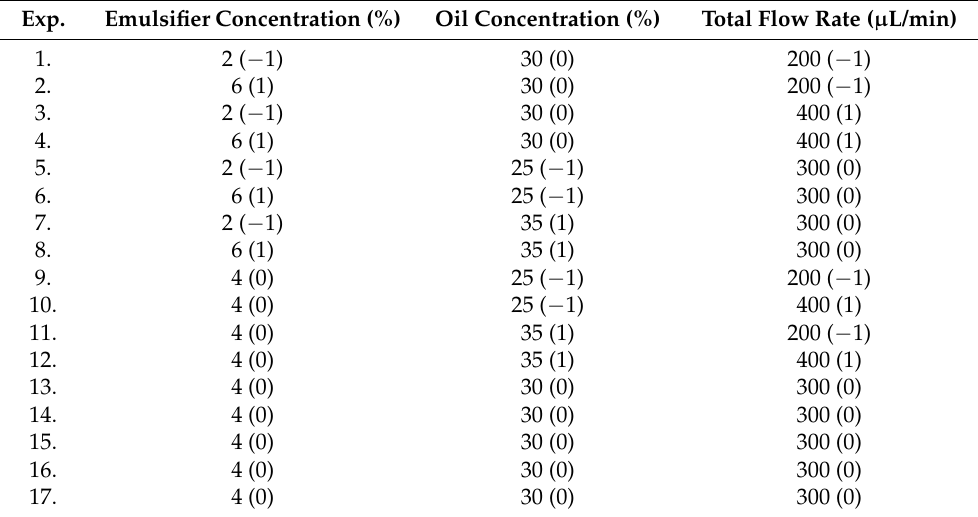
Table 1. Design of emulsification experiments. Levels of each input variable are given in brackets ( − 1, 1, and 0: low, medium, and high levels).